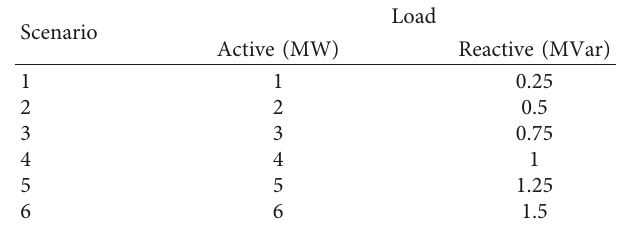
Figure 4: The 25kV 14-bus test distribution network under consideration. Table 1: The six loading scenarios for simulations.